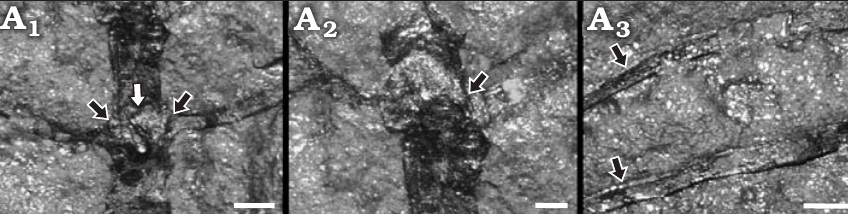
Fig. 5. Medusozoan cnidarian Sphenothallus sica Salter, 1856 (DNPM 329) from the Early Devonian Ponta Grossa Formation, Paraná State, southern Brazil. A 1 , marginal daughter tubes 5 and 6 (black arrows) and the isolated guyot-like feature (white arrow) between them; A 2 , side view of the guyot- like basal portion of marginal daughter tube 4 (arrow); A 3 , detail of daughter tubes 6 and 8, arrows indicate places where compaction has caused the intact marginal thickenings to appear as narrow, levee-like berms. Scale bars: A 1 , A 2 , 500 μ m; A 3 , 1 mm.